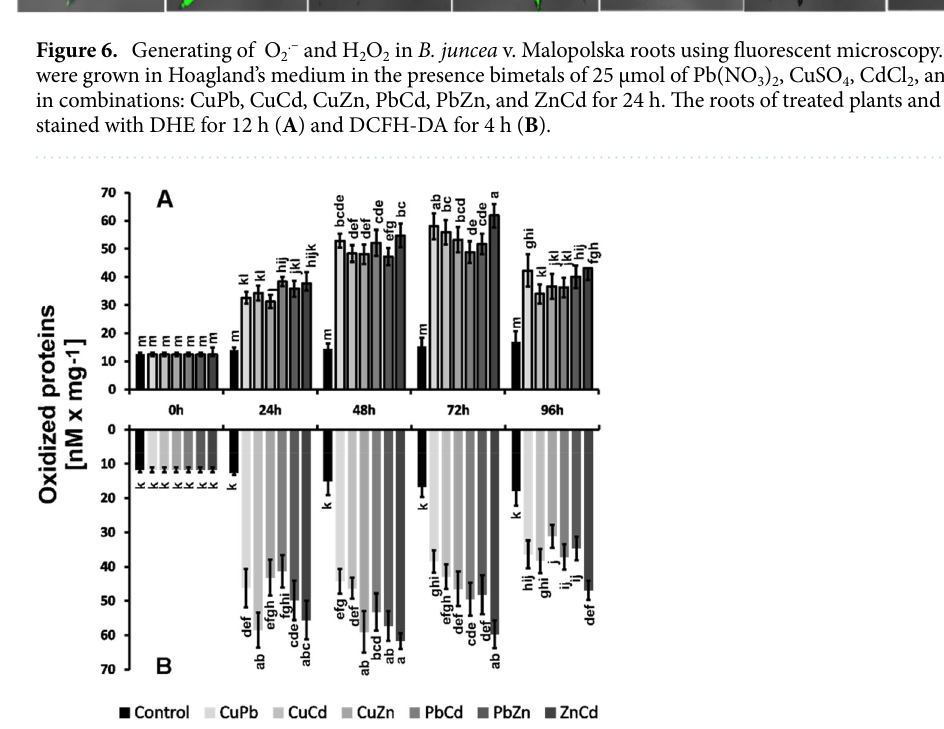
Figure 7. Oxidized protein level above-ground parts ( A ) and roots ( B ) of B. juncea v. Malopolska seedlings grown in Hoagland’s medium and treated with ions in combinations: CuPb, CuCd, CuZn, PbCd, PbZn, and ZnCd after 96 h of cultivation. Metal solutions Pb(NO 3)2 , CuSO 4 , CdCl 2 , and ZnSO 4 were applied at a 25 μM concentration of each. Mean values of three replicates (± SD), with results of Duncan’s Test, made separately for ( A ) and ( B